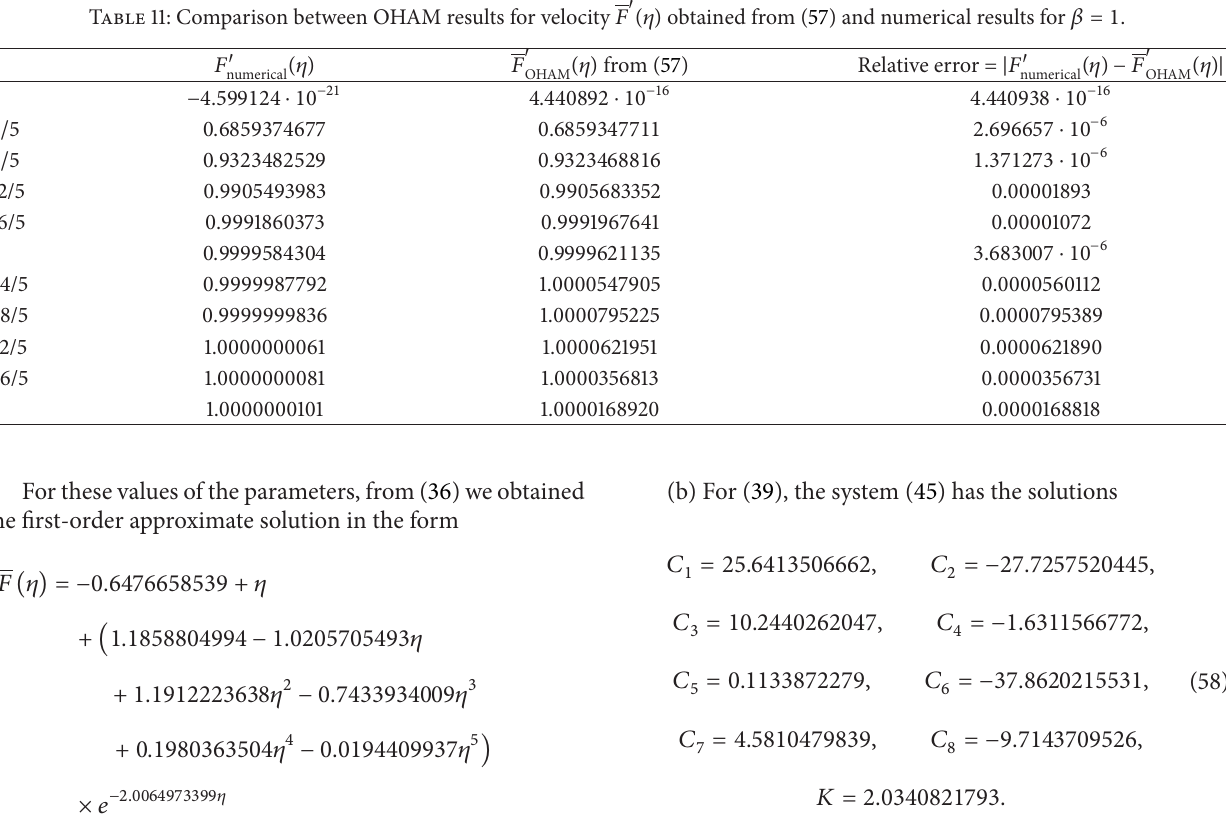
Table 11: Comparison between OHAM results for velocity 𝐹